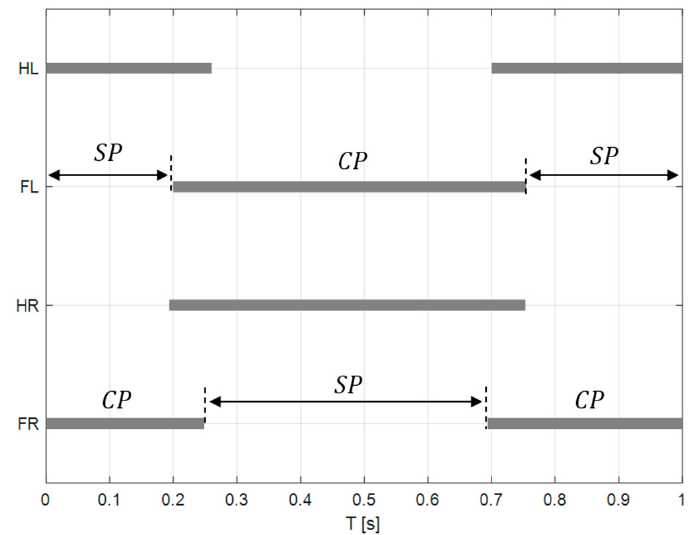
Figure 10. Gait sequence of the optimal walking trot solution: 𝐹𝐿 (front left), 𝐹𝑅 (front right), 𝐻𝐿 (hind left), 𝐻𝑅 (hind right), CP (contact phase), and SP (swing phase).